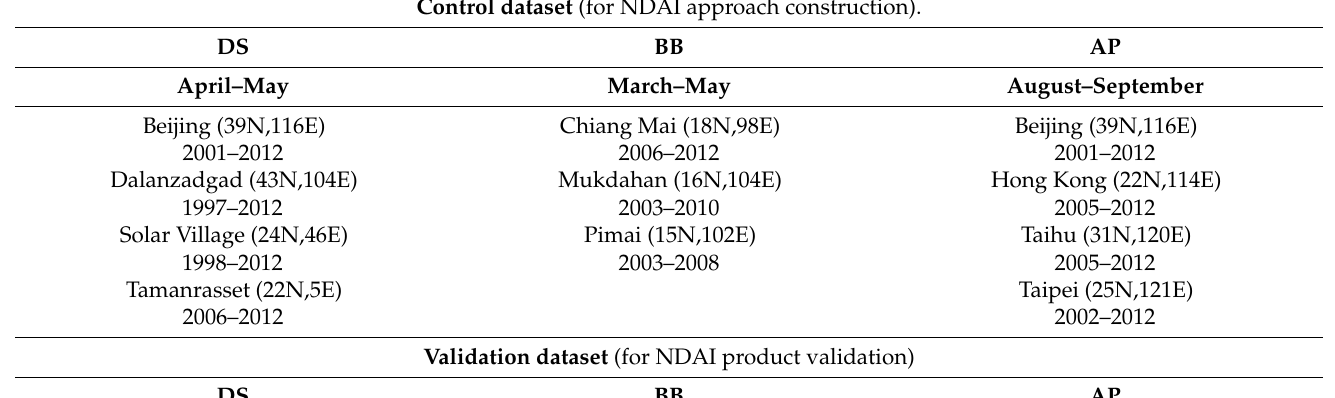
Table 2. The control dataset and validation dataset from source regions of AERONET sites for aerosol type identification during the periods from 1997 to 2012 and 2014 to 2016, respectively. NDAI: normalized difference aerosol index. Control dataset (for NDAI approach